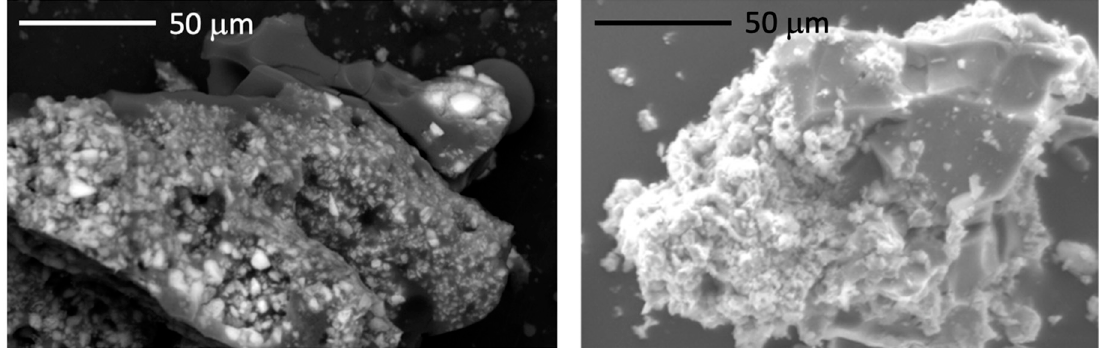
Figure 7. SEM image of the composite obtained from the pyrolysis of l -PZCS ( left ) compared to that of a composite generated by the pyrolysis of a commercial polymer (PCMS) mixed with ZrC powders ( right ) [31].